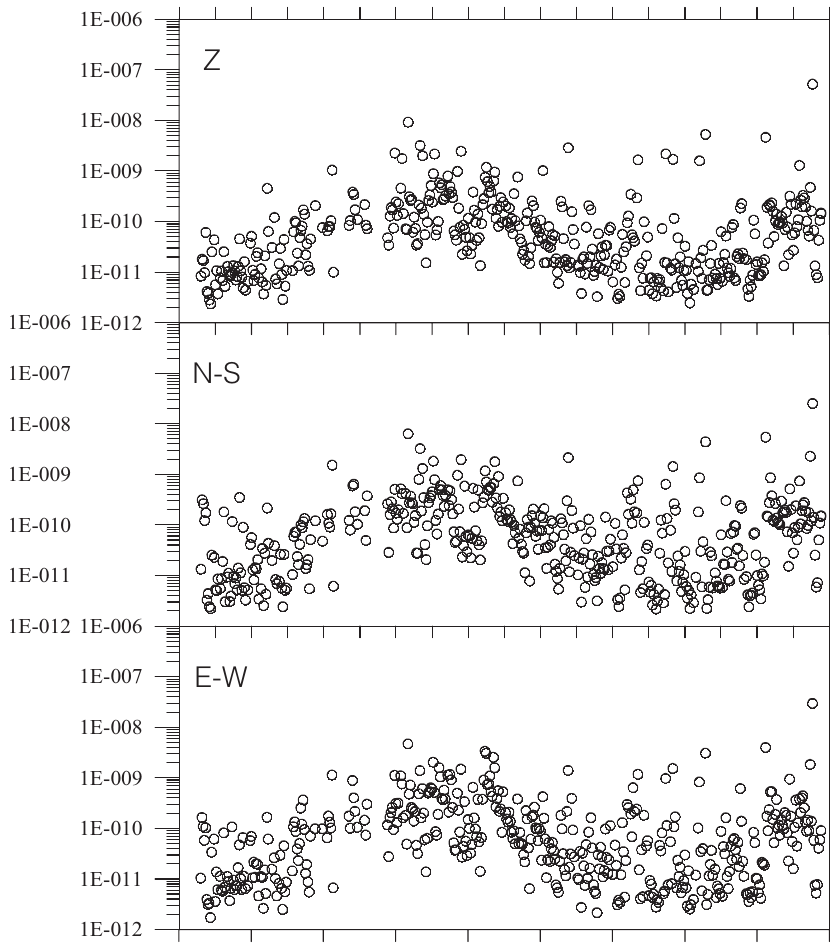
Fig. 8. Seasonal variation of the velocity power spectra peak for three-component secondary